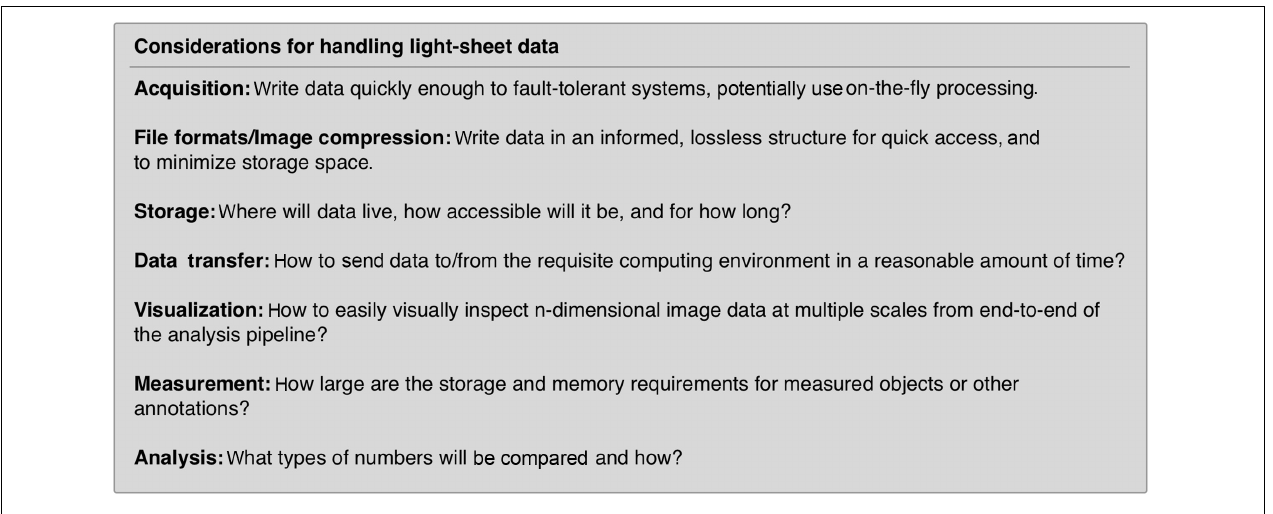
FIGURE 2 | Data handling steps that require special attention with light-sheet image data. If possible, it is advantageous to select a compressed file format that can be utilized by the requisite analysis software. Unfortunately, not all analysis software can read all image formats and often data must be resaved or restructured as it travels through an analysis